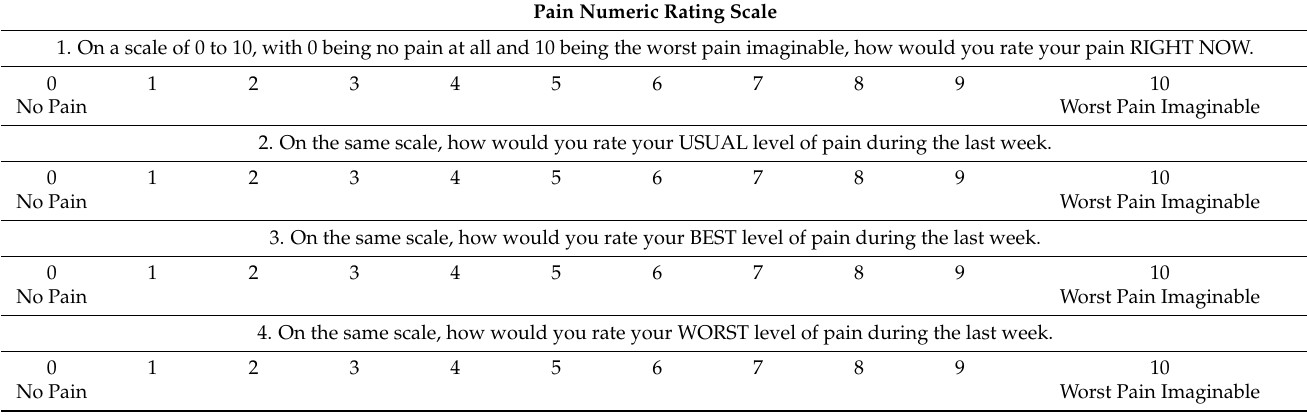
Table A2. Numeric Pain Rating Scale (NPRS) [257].